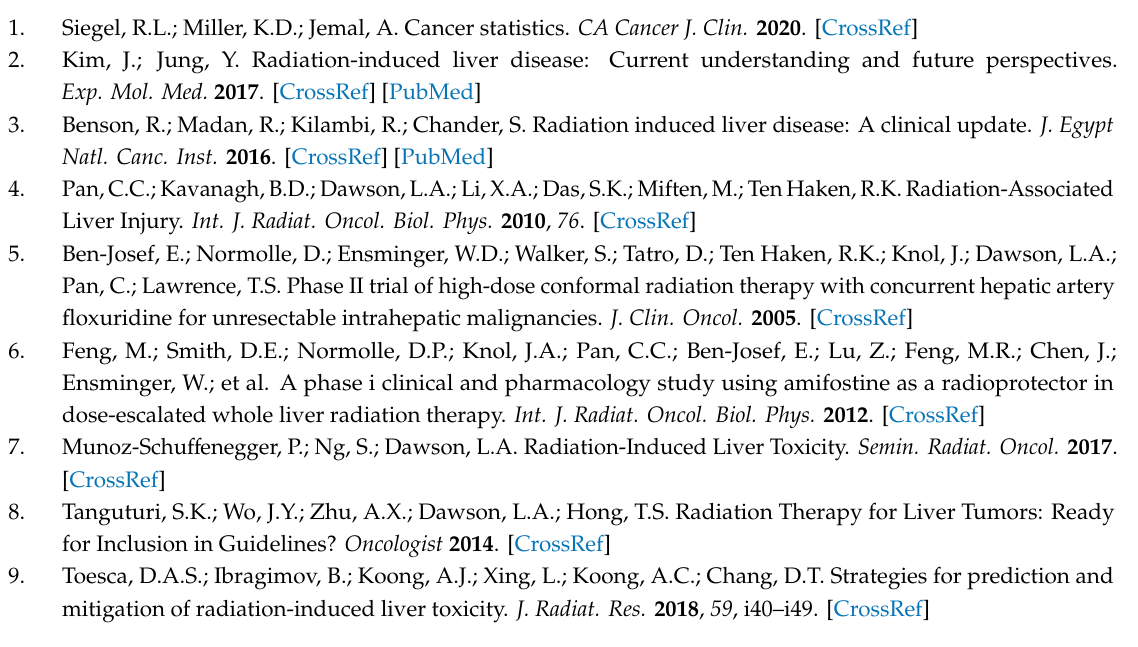
Figure S1: Conjugated and unconjugated plasma bilirubin levels did not show any significant changes between the sham and irradiated mice from both homozygous or SIRT3 knockout genotype, Table S1: Primers used in the single gene quantitative RT-PCR